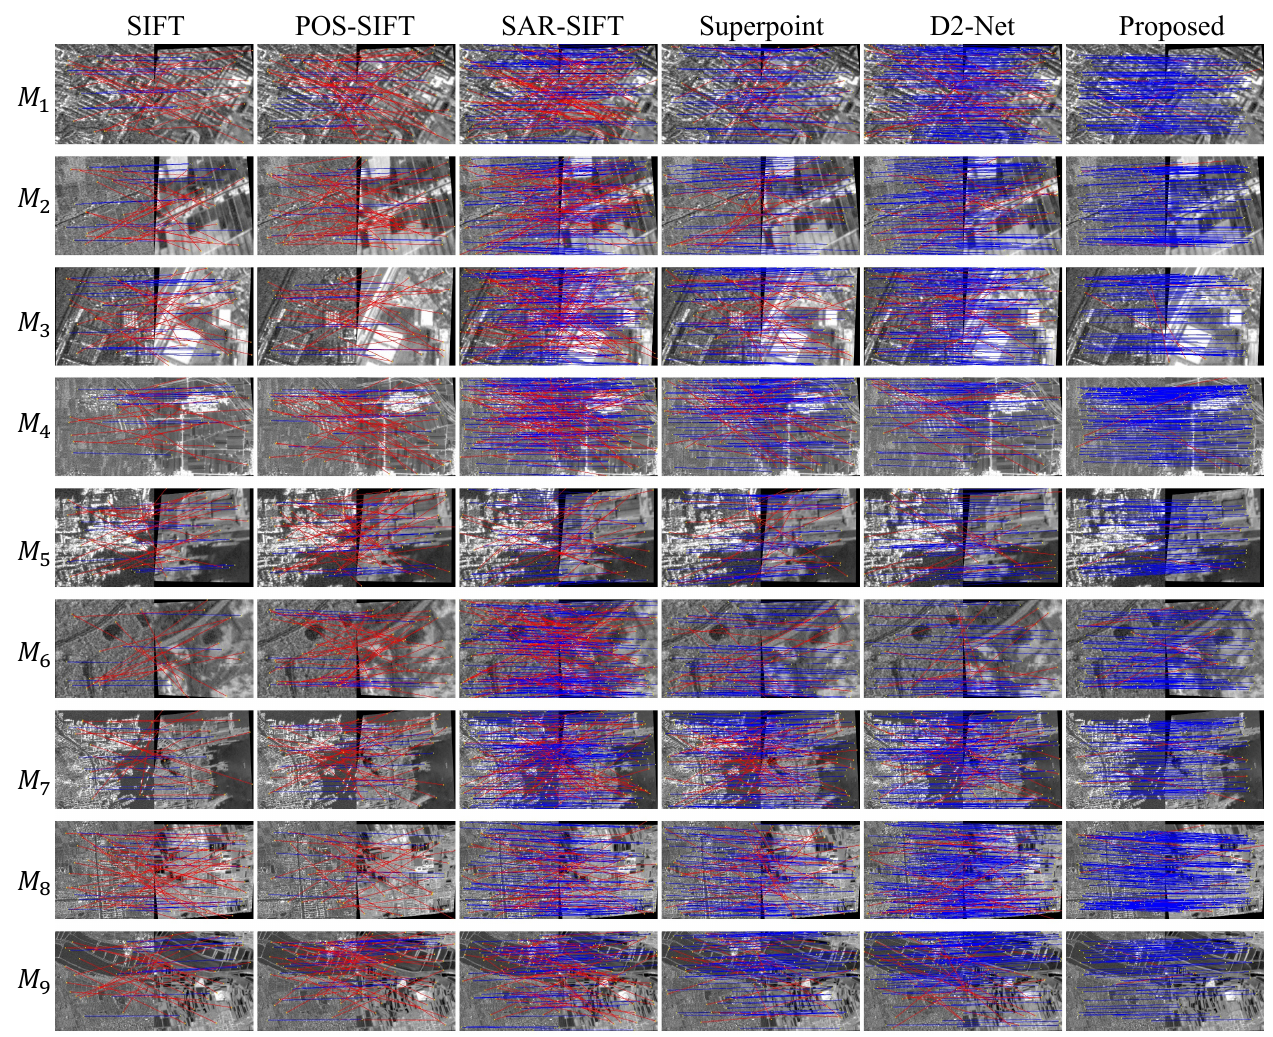
Figure 10. Qualitative matching results by the overall network on M 1 . . . M 9 , where the blue lines indicate correct matching and the red lines indicate incorrect correspondences. Table 4 listed the quantitative comparison among five methods. The M.S. and